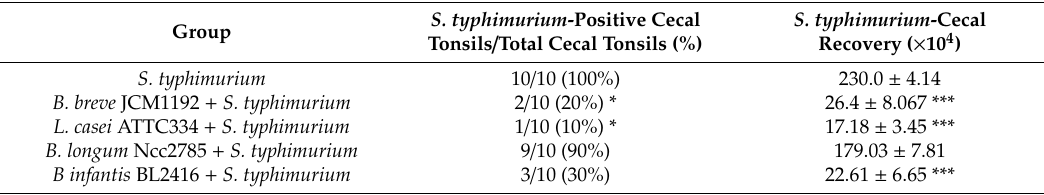
Table 3. S. typhimurium recovered from the cecal tonsils and cecal contents of chicks treated with di ff erent probiotic